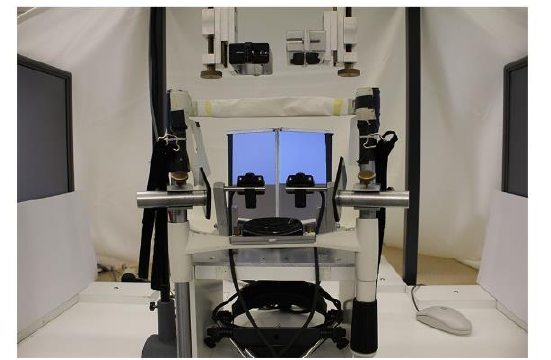
Figure 1. Picture of the experimental set-up. Two mirrors in the centre reflect the image of each screen to one eye only. The cameras of the Eyelink II system were positioned as close as possible to the participants’ eyes to enable maximal measurement resolution and field